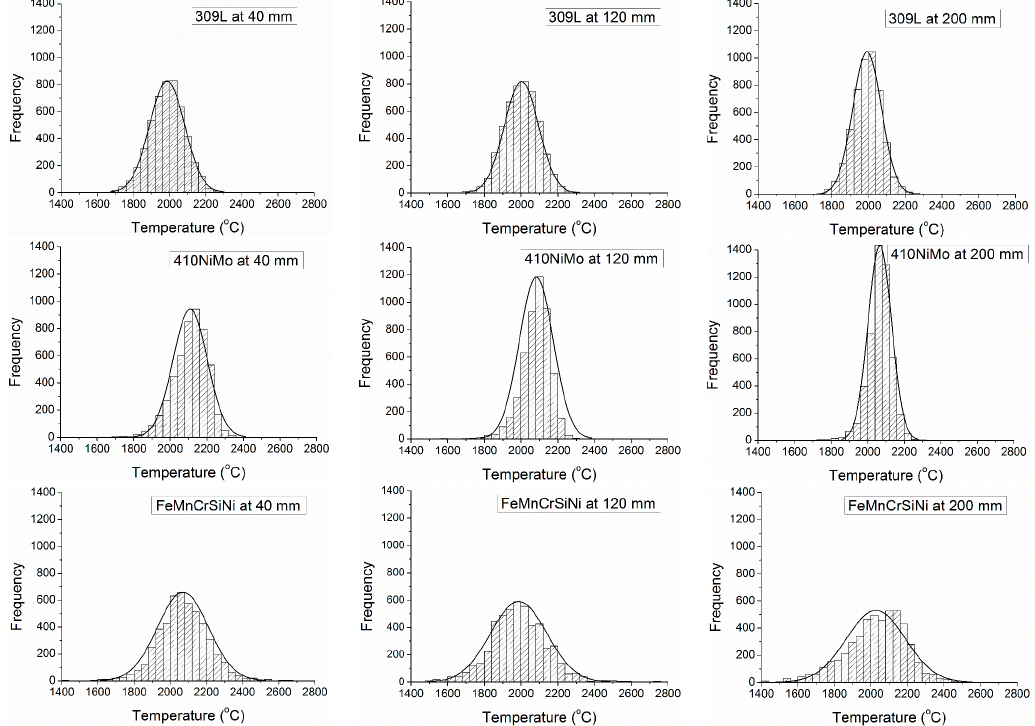
Figure 7. Histograms of temperature of particles versus distance from the gun.